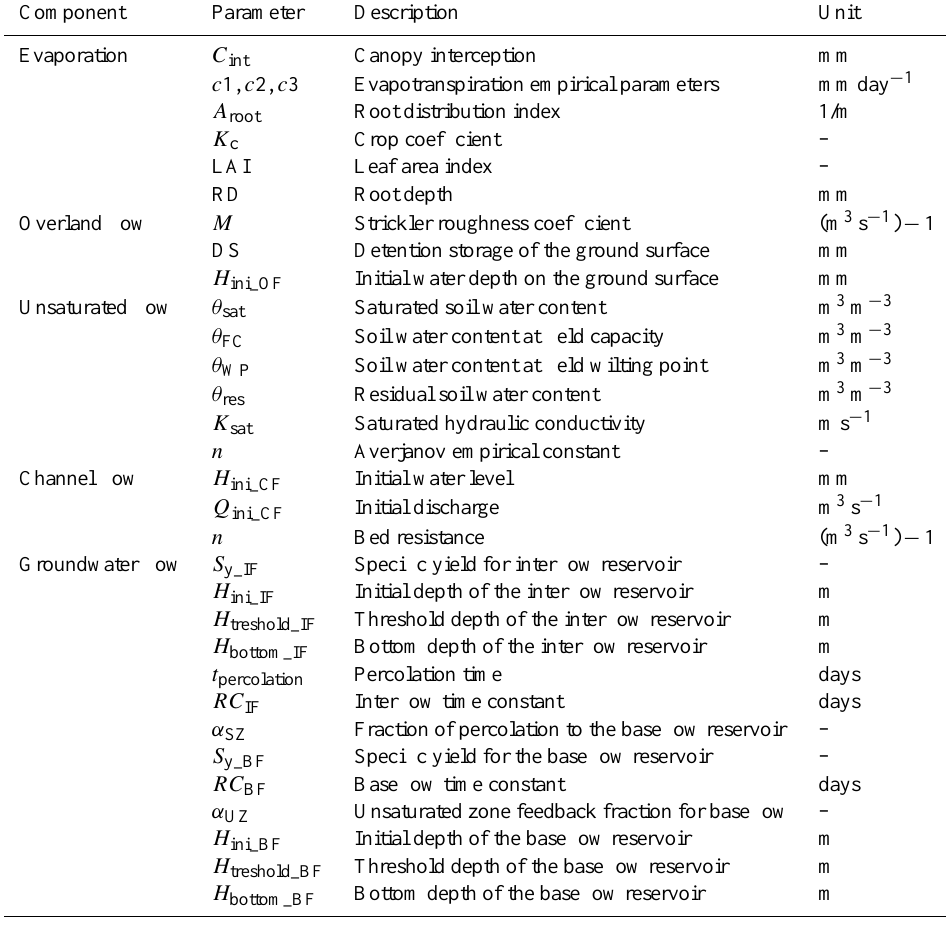
Table 2. Overview of the MIKE SHE model parameters in the considered model